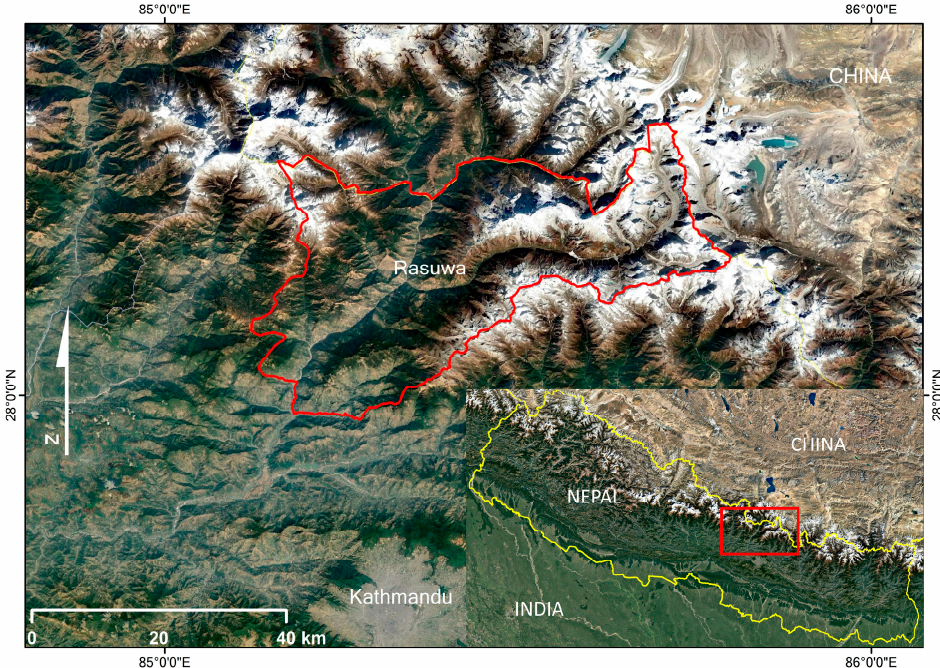
Figure 1. Study area in Rasuwa, Nepal.